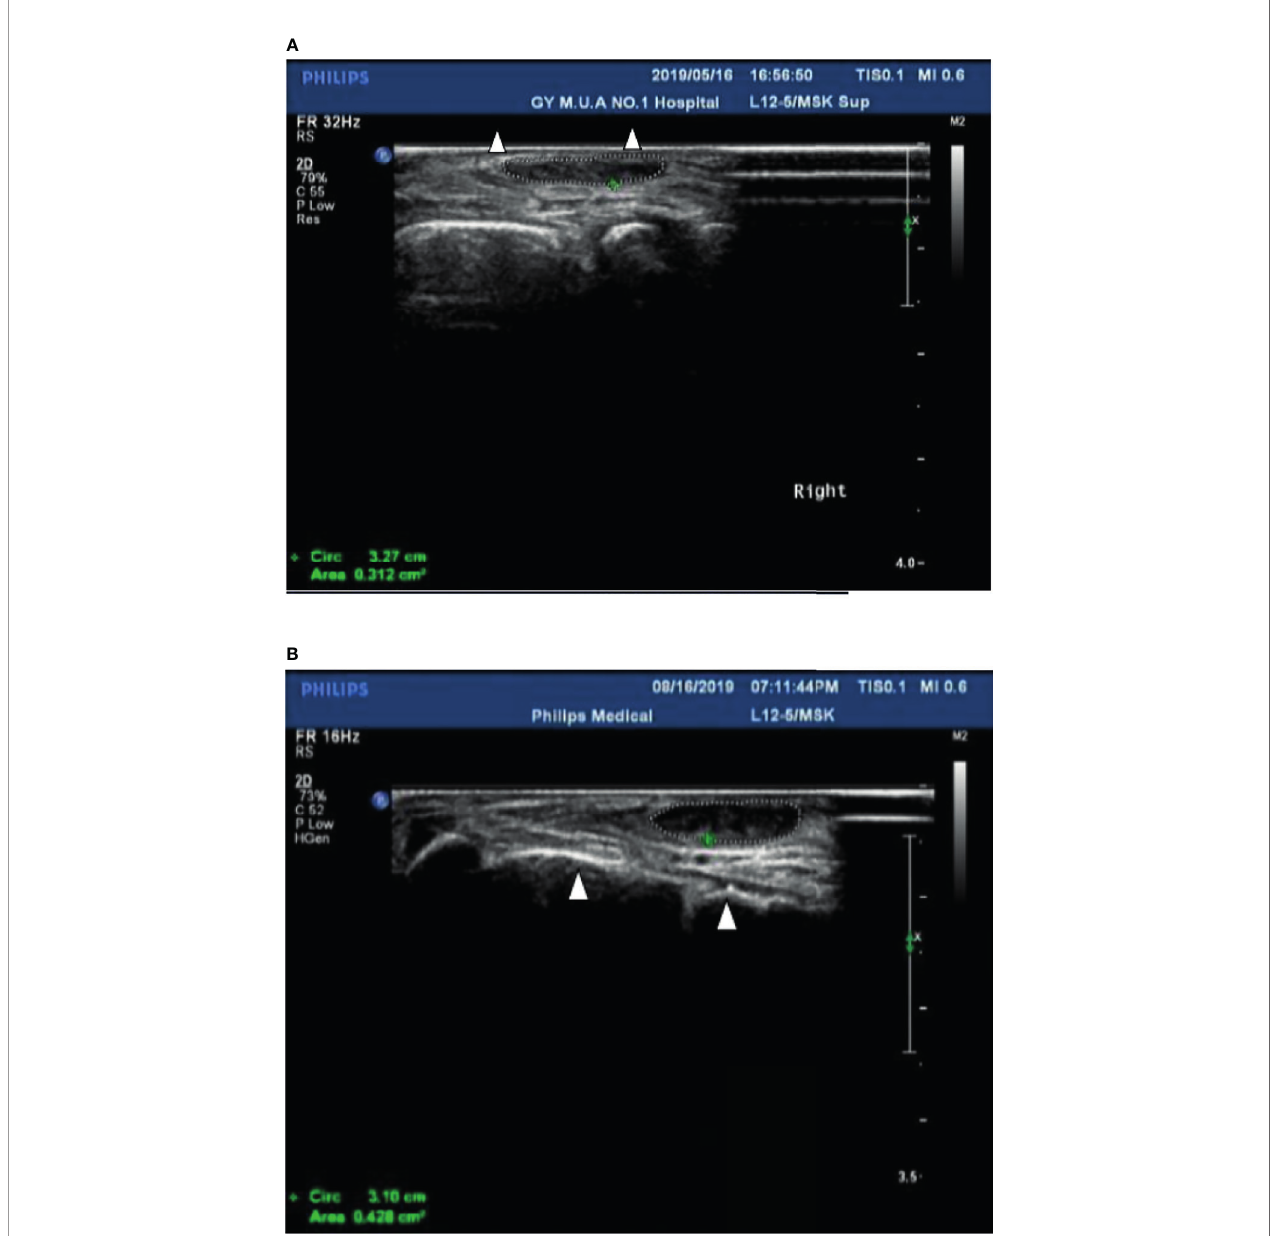
FIGURE 1 | (A) The cross-sectional area of the extensor digitorum brevis of patient 1 before treatment was 0.312 cm 2 (Circled by a dotted line); The Triangle refers to the fourth and fi fth metatarsal bones. (B) The cross-sectional area of the extensor digitorum brevis increased to 0.428 cm 2 (Circled by a dotted line) after two courses of treatment; The Triangle refers to the fourth and fi fth metatarsal